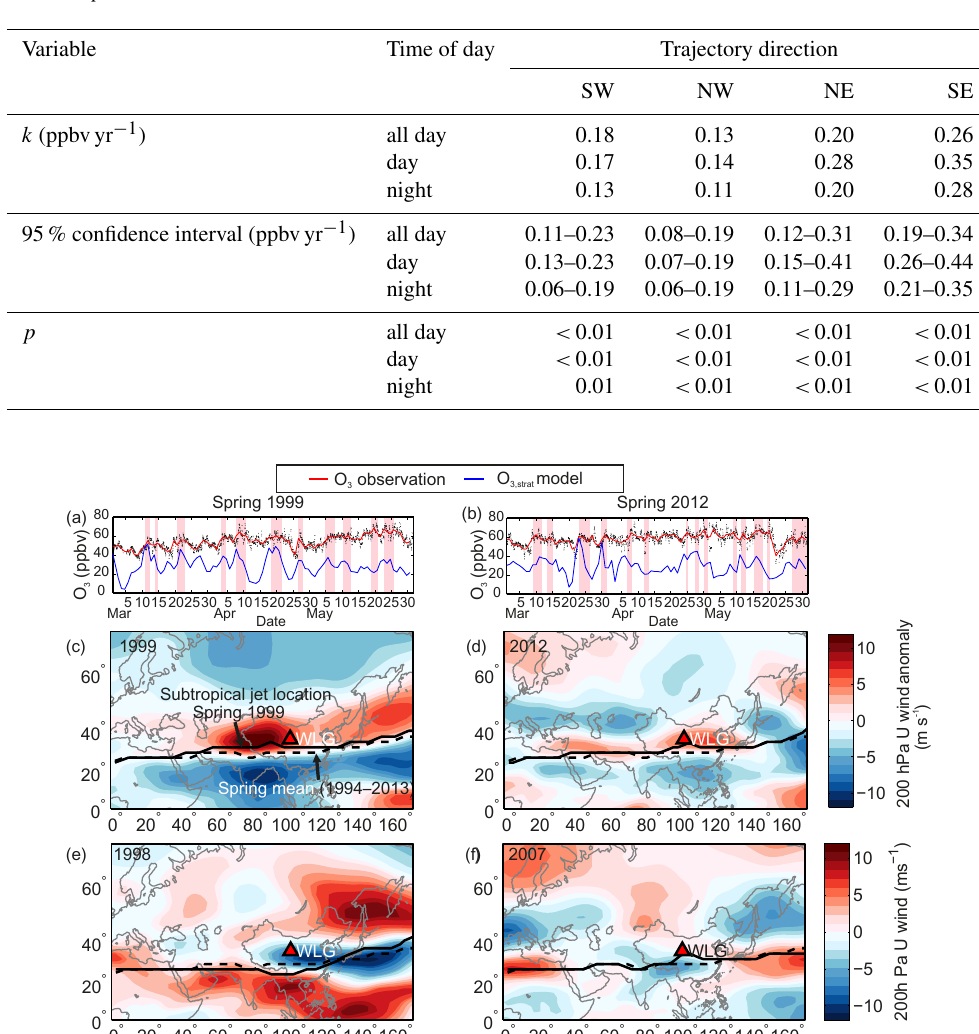
Figure 11. Temporal variations in (a) hourly (black dots) and daily (red line) mean surface ozone observations and modelled O 3 Strat (blue line) from March to May in 1999 and 2012; (b) 200hPa zonal wind anomaly in the springs of 1999 and 2012 with the strong stratospheric influence; (c) same as (a) but for the springs of 1998 and 2007 with weak stratospheric